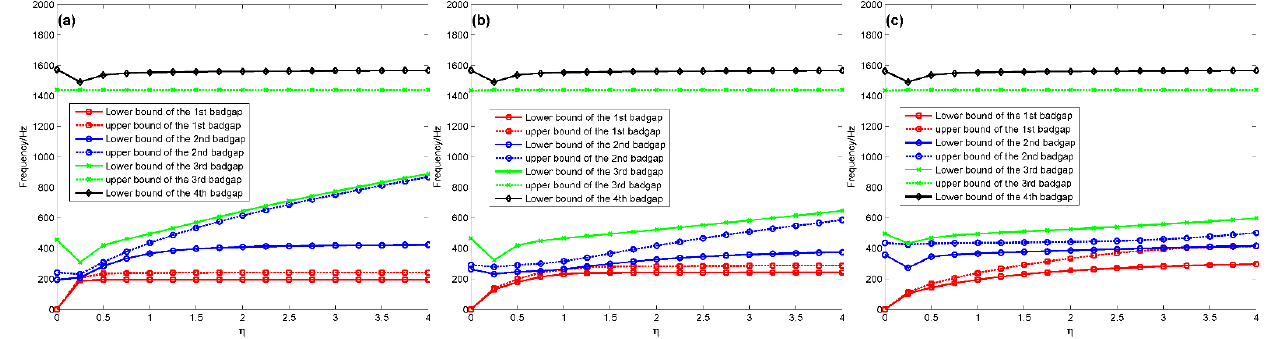
Figure 8. Lower and upper borders of the bandgaps for the infinite coupling strut: ( a – c ) as a function of η when θ = 0.2, θ = 0.5 and θ = 0.8,